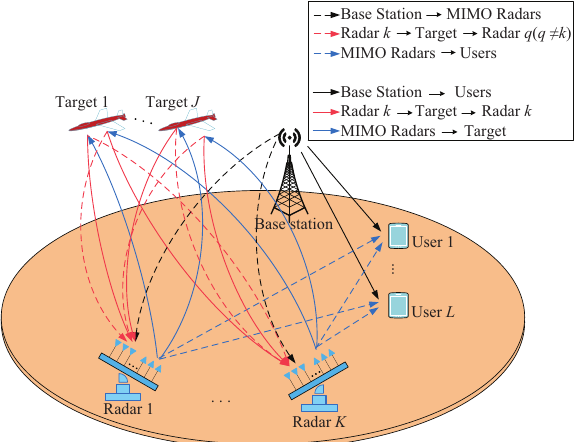
Figure 1. Multistatic multiple-input multiple-output (MIMO) radar network with multi-user (MU)